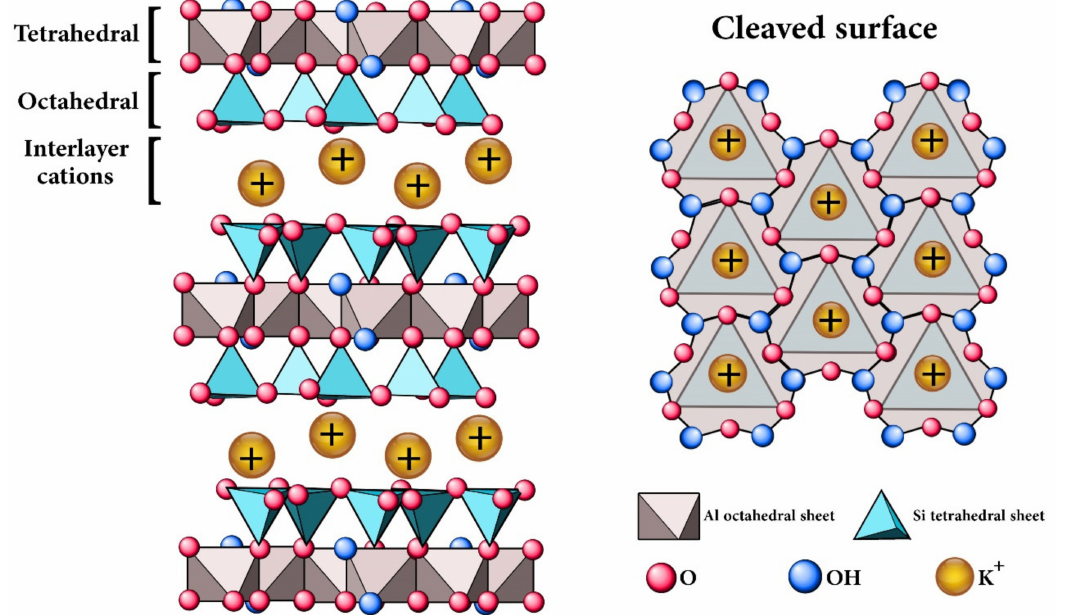
Figure 1. The schematic structure of mica mineral with lamellar